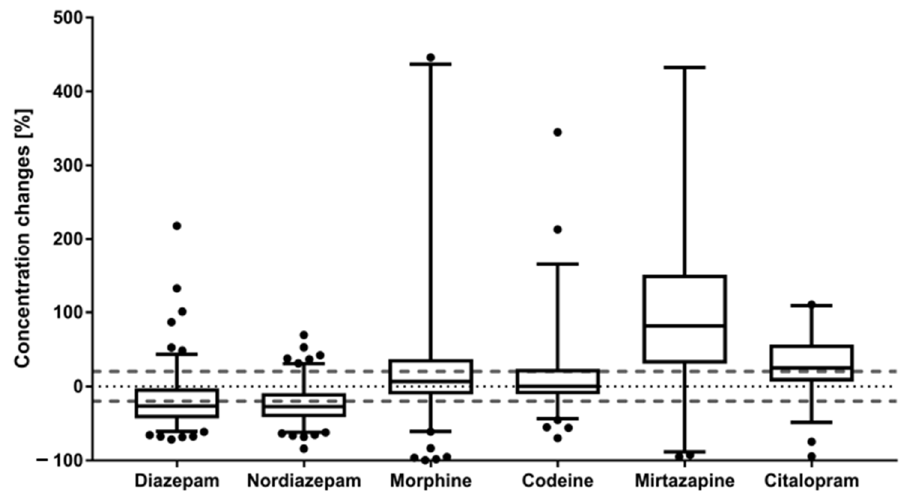
Figure 1. Percentage concentration changes are displayed for the six studied drugs (of abuse) in box-whisker plots; whiskers indicate the 5–95% percentile; within the boxes, the median is displayed; y-axis was cut at 500% for better visibility, but cases above 500% concentration changes were included for the statistics (above 500%: morphine: n = 5; codeine: n = 2; mirtazapine: n = 2; citalopram: n = 2); dotted line indicates 0% change; dashed lines indicate ± 20% change